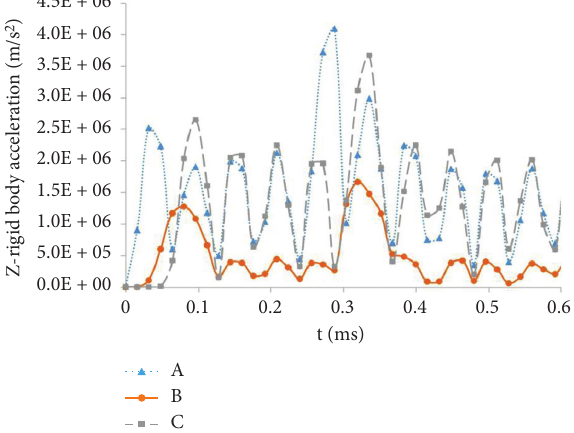
Figure 15: Z-directional acceleration curve at different positions of the